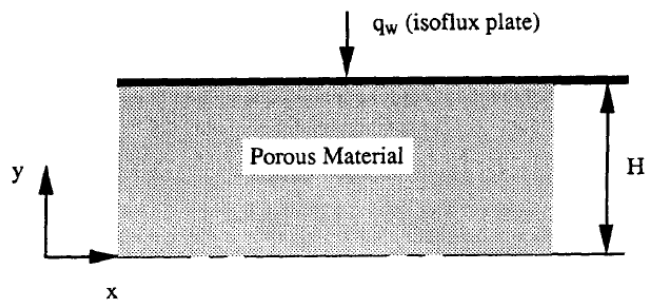
Figure 4. Physical problem solved by Kuznetsov